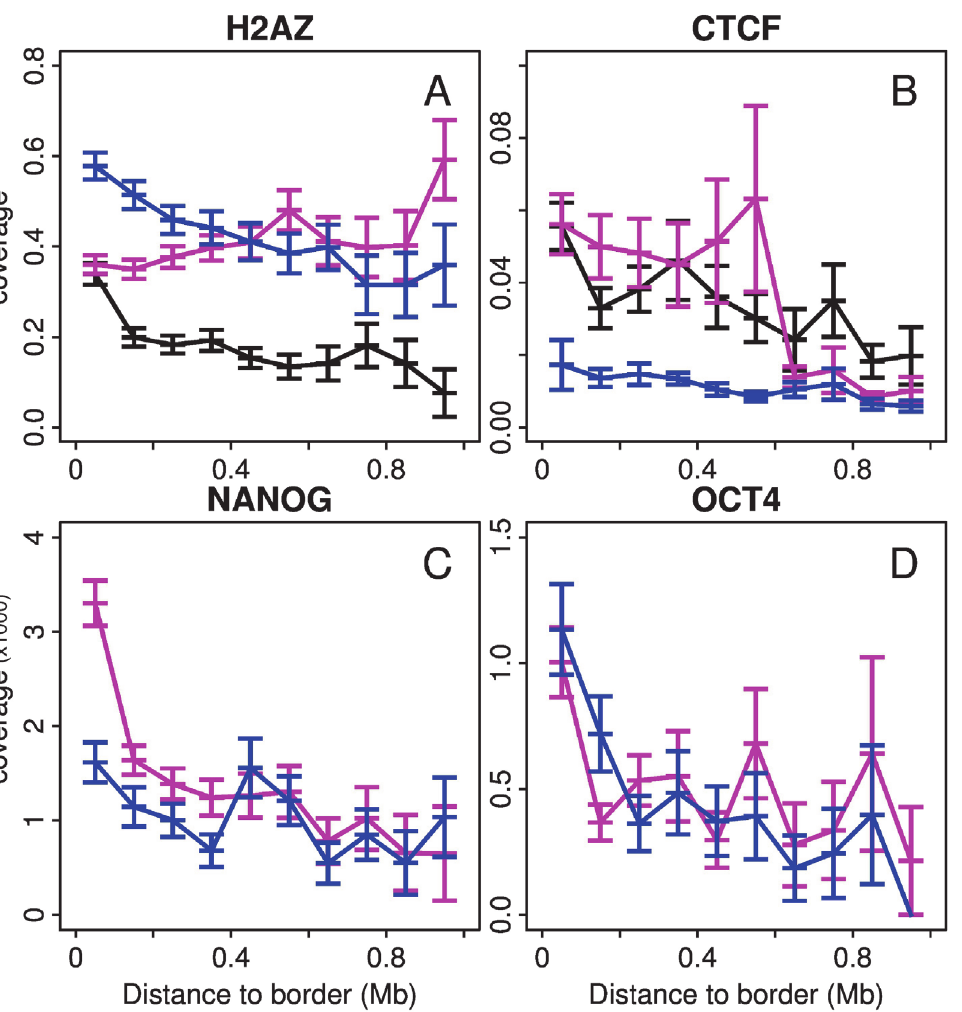
Figure 8. Epigenetic marks enrichment in specific MRT U-domains of H1hesc and Nhdfad. (A) Mean coverage of H2AZ enriched intervals with respect to the distance to the closest U-domain border specific to the cell line. The different colors correspond to specific U-domains of Nhdfad (black), specific U-domains of H1hesc whose border is in EC1 or EC2 (red) and specific U-domains of H1hesc whose border is in EC4 (blue). (B), (C) and (D) are as (A) for respectively CTCF, NANOG anf OCT4. Note that in (C) and (D) coverage are per